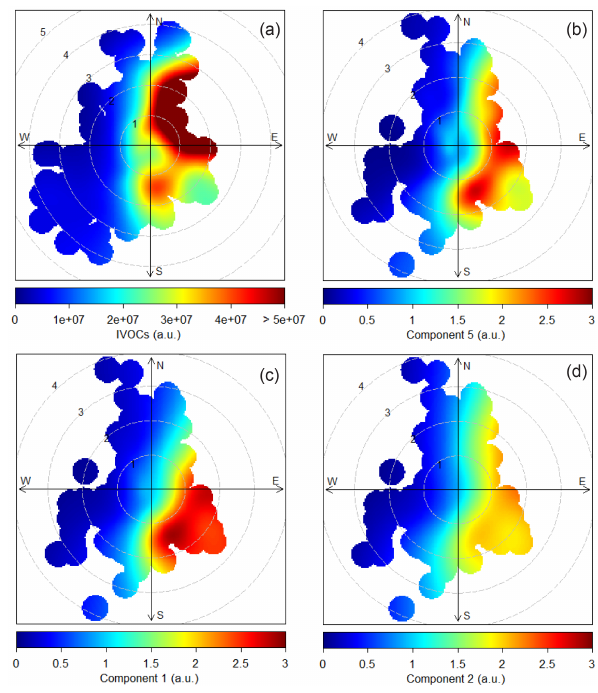
Figure 5. Bivariate polar plots related to IVOCs. (a) IVOCs from the complete data set. (b) Component 5 extracted from the main PCA (Table 5). (c) Component 1 extracted from the main PCA. (d) Component 2 extracted from the main PCA. Wind direction is binned into 10 ◦ intervals and wind direction into 30 ◦ intervals. The polar axis indicates wind speed (ms − 1 ). a.u. is arbitrary